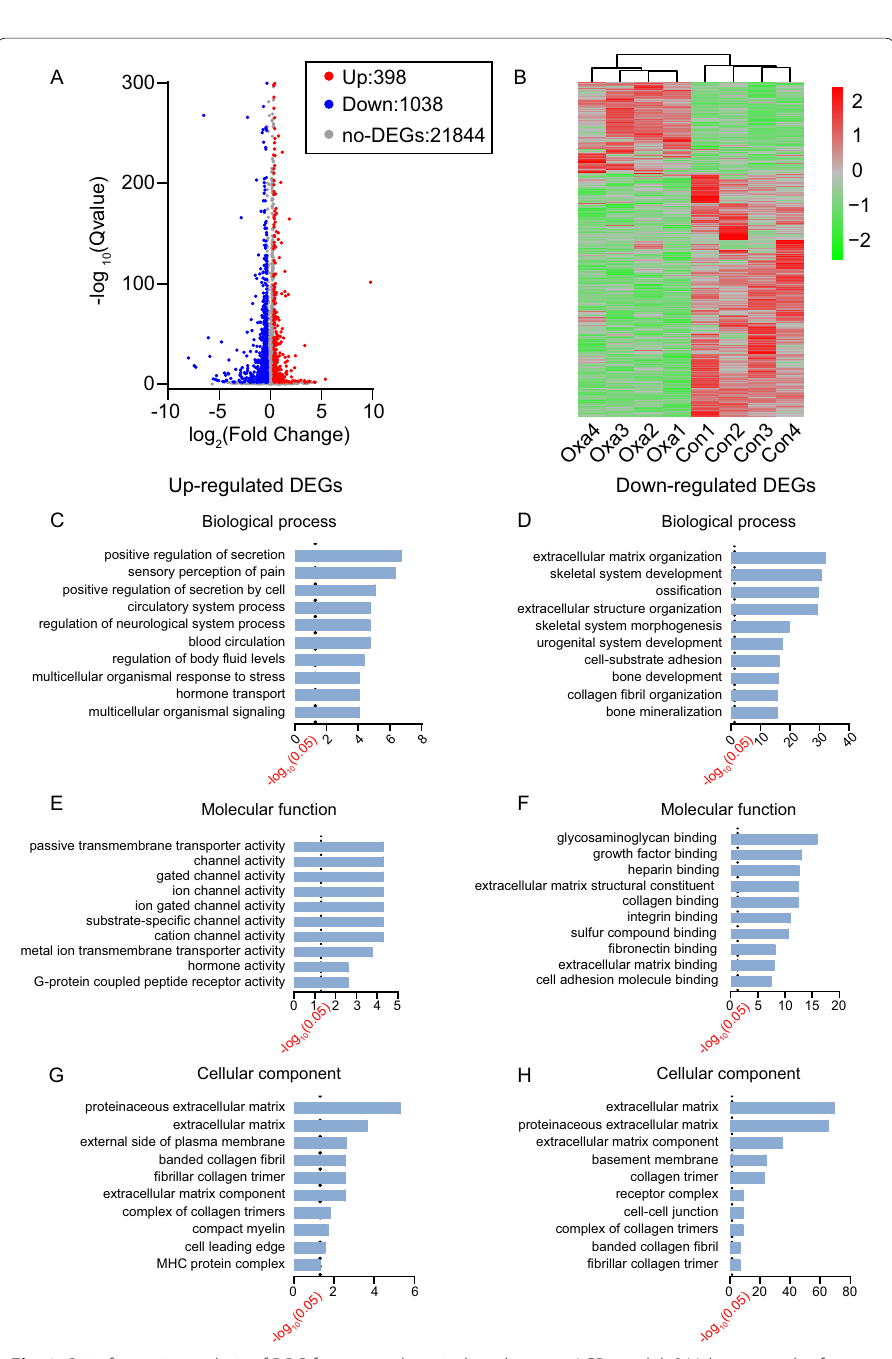
Fig. 2 Bioinformatics analysis of DRG from oxazolone-induced mouse ACD model. A Volcano graph of mRNA expression in DRG of oxazolone (Oxa) group versus control (Con) group. Dots with different colors indicate corresponding expression changes. B Heatmap illustration of the hierarchical clustering of DEmRNAs of oxazolone group versus control group. C , E , and G The top ten most significantly enriched biological processes, molecular functions, and cellular components of upregulated DEmRNAs. D , F , and H The top ten most significantly enriched biological processes, molecular functions, and cellular components of downregulated DEmRNAs. The dotted line indicates q -value of